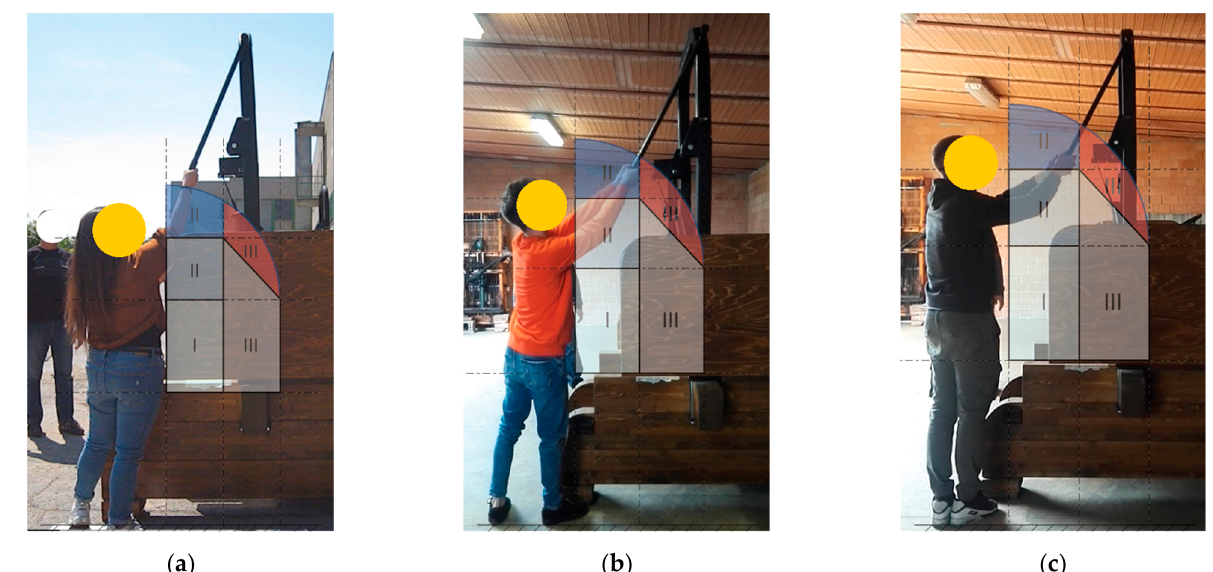
Figure 11. The three users corresponding to ( a ) the 5th percentile, ( b ) the 50th percentile, and ( c ) the 95th percentile involved in prototype testing, while performing the requested task of raising the FROPS. The redesigned accessible zones were overlapped to the photographs to verify their feasibility in actual conditions.